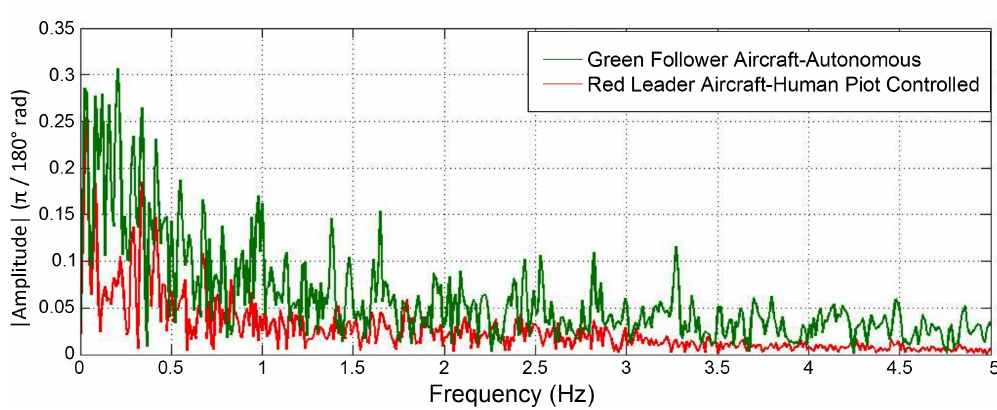
Figure 12. Amplitude spectrum of elevator command during formation flight for